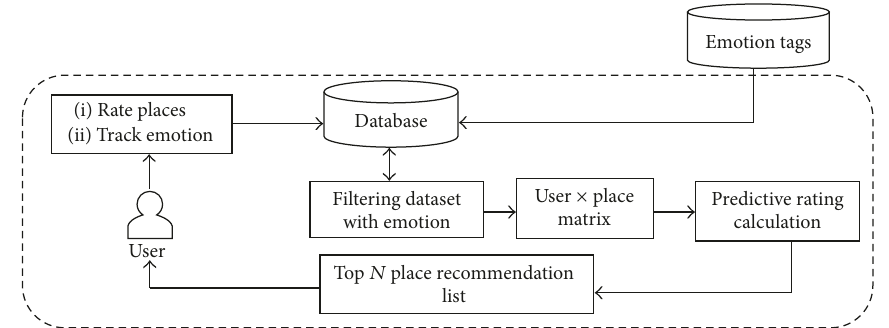
Figure 5: Recommendation process.